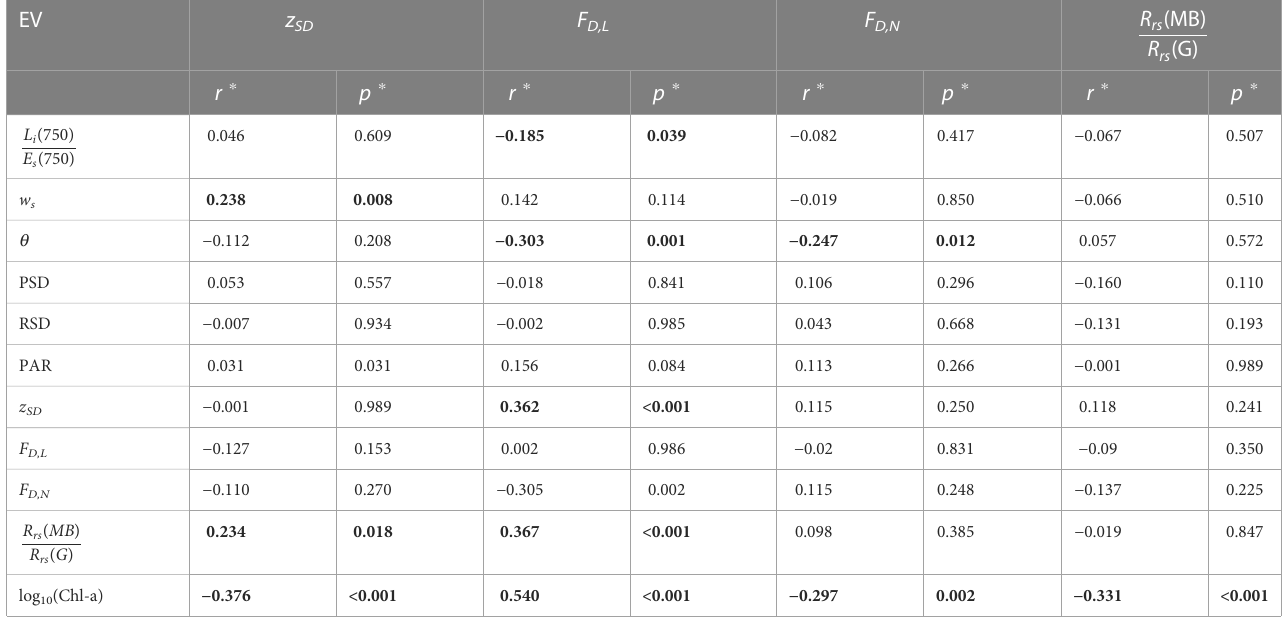
TABLE 3 Residuals between estimated log 10 (Chl-a), from Z SD , F D,L , F D,N and R rs (MB)/ R rs (G) (independent variables), and measured log 10 (Chl-a), correlated with environmental variables (EV).